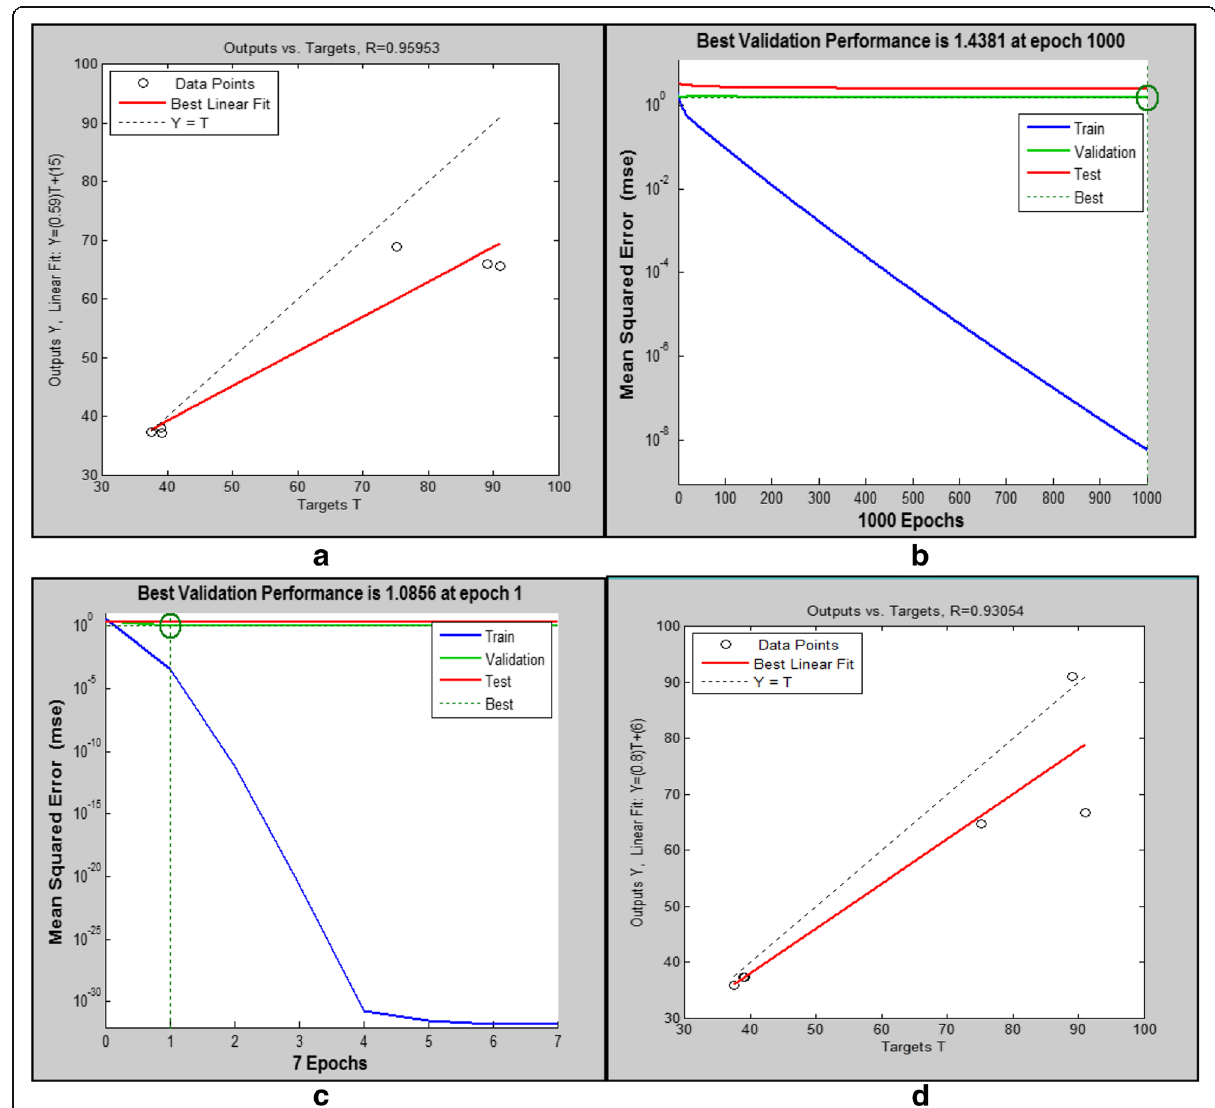
Fig. 2 a Post-regression plot (GD). b Network performance plot (GD). c Network evaluation regression plot (LM). d Network simulation with new inputs (LM)